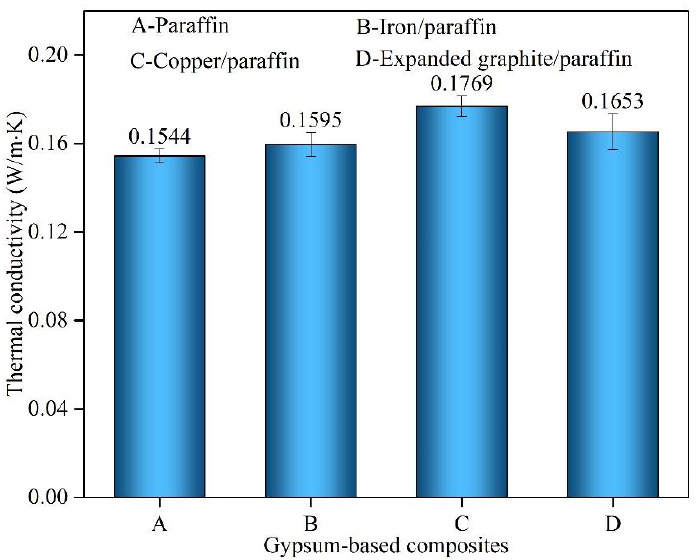
Figure 4. Thermal conductivities of the PA/gypsum and TC/PA/gypsum composites. Fracture morphologies of the cross sections of the PA/gypsum and TC/PA/gypsum composites are shown in Figure 5. The spherical white pits and black parts were left by the PA (Figure 5a). The fracture morphology between the PA and gypsum matrix indicates